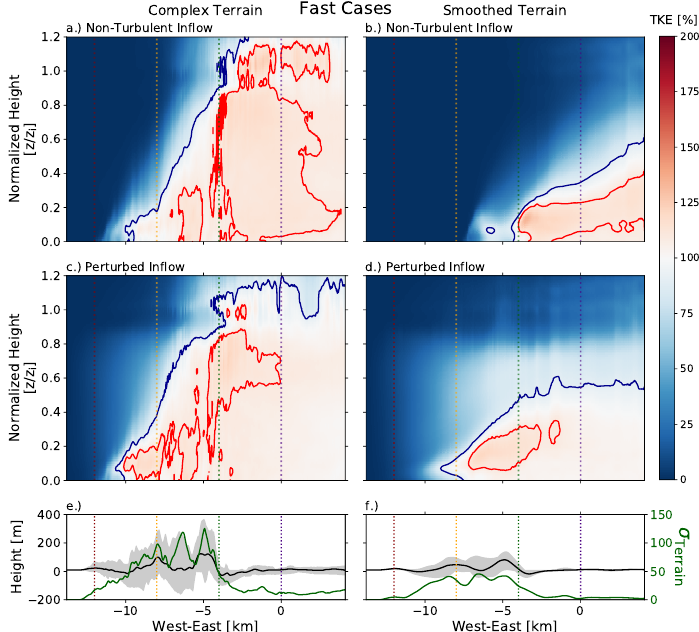
Figure 18. Same as Figure 15 but for the Fast cases. Panels ( a – d ) show the percentage of time- averaged TKE averaged along the y -direction with normalized height. Dark blue lines contour the 90th-percentile and red lines contour the 110th-percentile. Panels e and f show the y -average of terrain height (black line) with the maximum and minimum of terrain heights (filled gray) on one axis and the variance of terrain height along the y-direction (green) on the opposite axis. Panels ( a , c , e ) (left column) show fields for simulations over complex terrain. Panels ( b , d , f ) (right column) show fields for simulations over smoothed terrain. Panels ( a , b ) show results for non-turbulent cases, while c and d show results for the perturbed